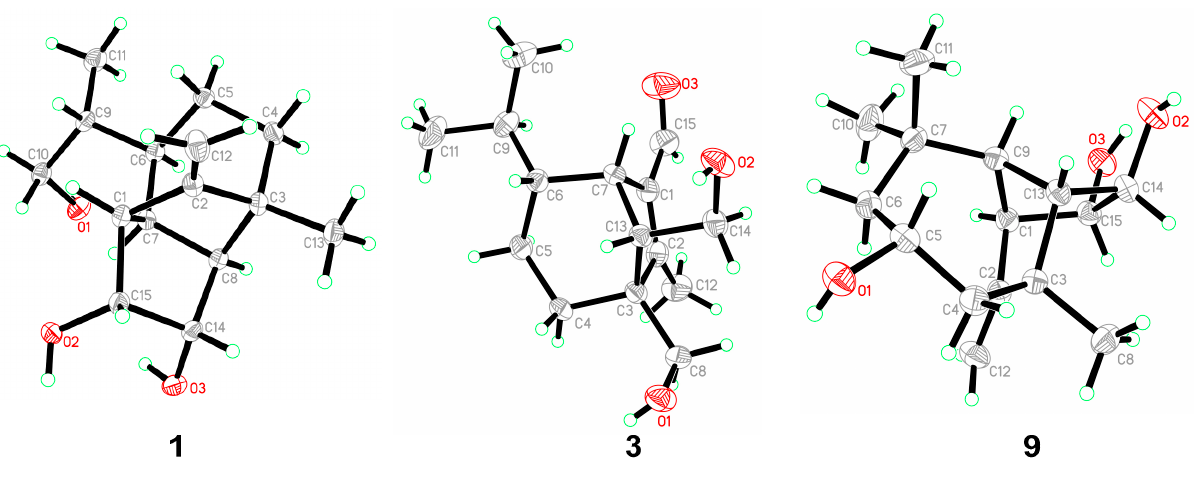
Figure 3. Key ROESY correlations for 1 , 3 , 5 , 6 , 7 , 9 , 10, and 12 .